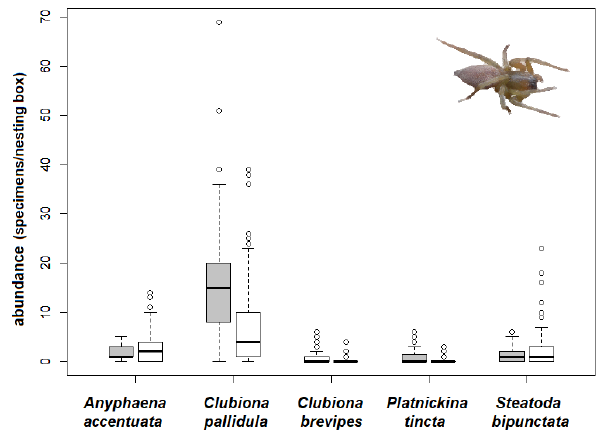
Figure 5 . Number of spider specimens per box and inspection (abundance) of dominant spider species in nesting boxes with nest material (grey) and without nest material (white), the bold lines in the boxplot are the median and the lines are 95% CI, the dots are outliers.